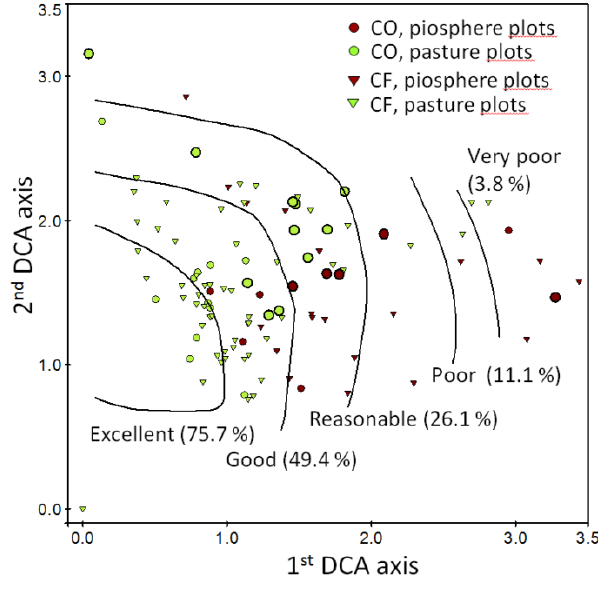
Fig. 2. Detrended correspondence analysis (DCA) diagram visualizing differences in floristic composition and rangeland condition. Piosphere plots (brown) and pasture plots (green) under communal management (CO) in the focal social- ecological system (small circles: Middeldeel, large circles: Sediba) are compared to those in the benchmark system of commercial farms (CF; triangles). Contours delineate rangeland condition classes (excellent to very poor) based on relative abundances of the bunchgrass Themeda